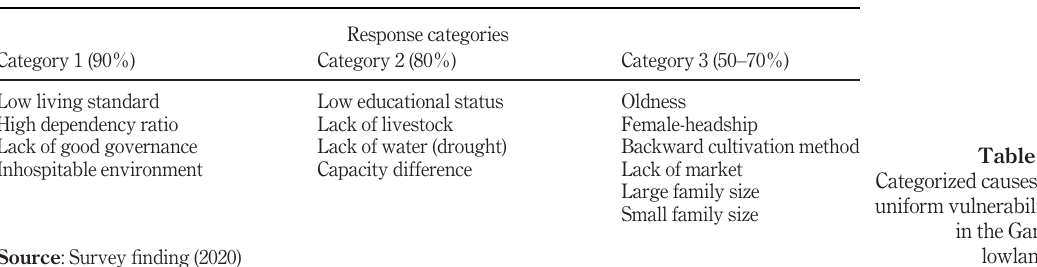
Table 5. Categorized causes